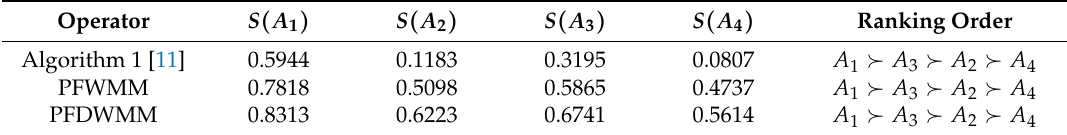
Table 9. The score values and ranking results of four Internet stocks.